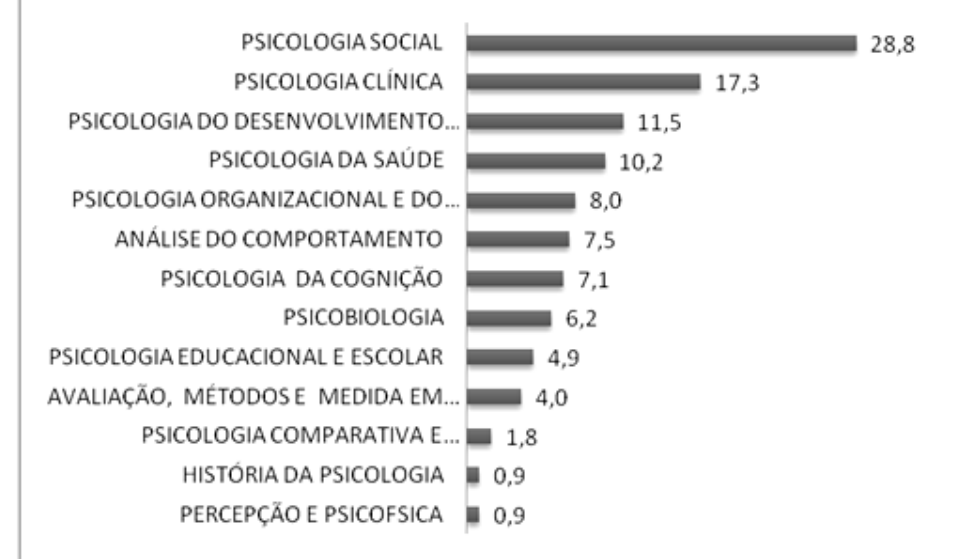
Figura 2 . Distribuição percentual das Linhas de Pesquisa agrupadas por